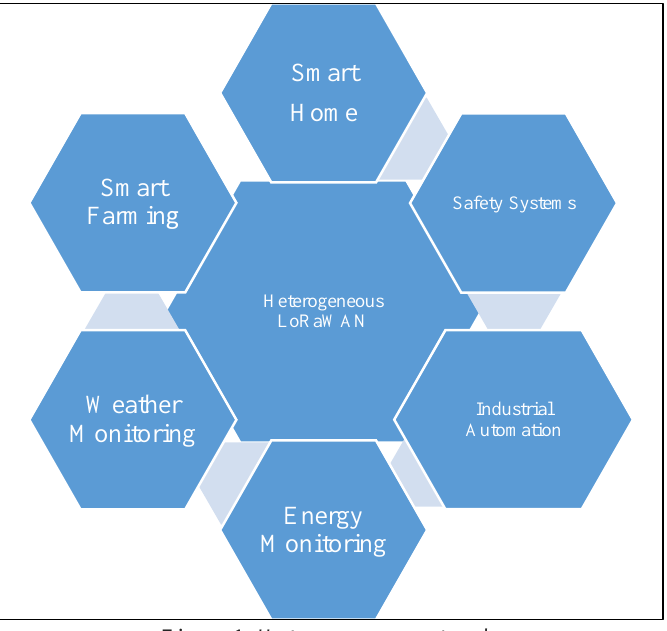
Figure 1: Heterogeneous network. Source: Authors,